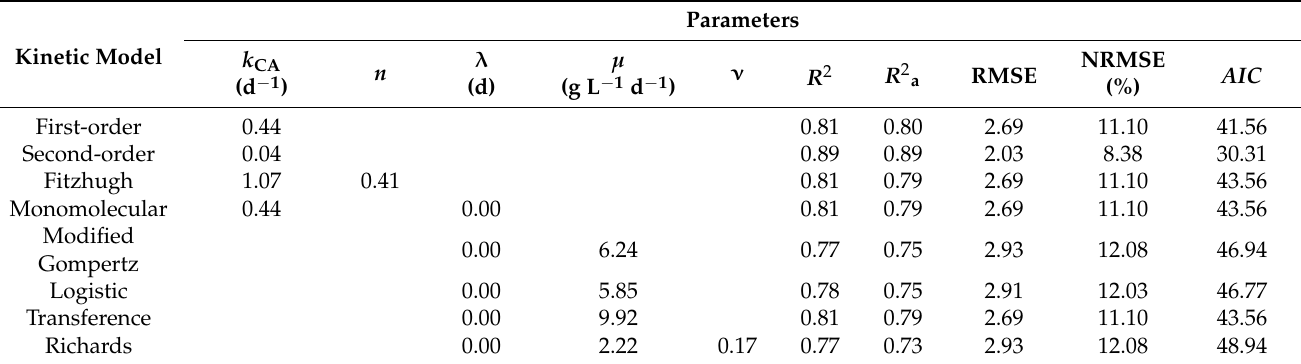
Table 4. Kinetic parameters were estimated by modeling the VFAs production from